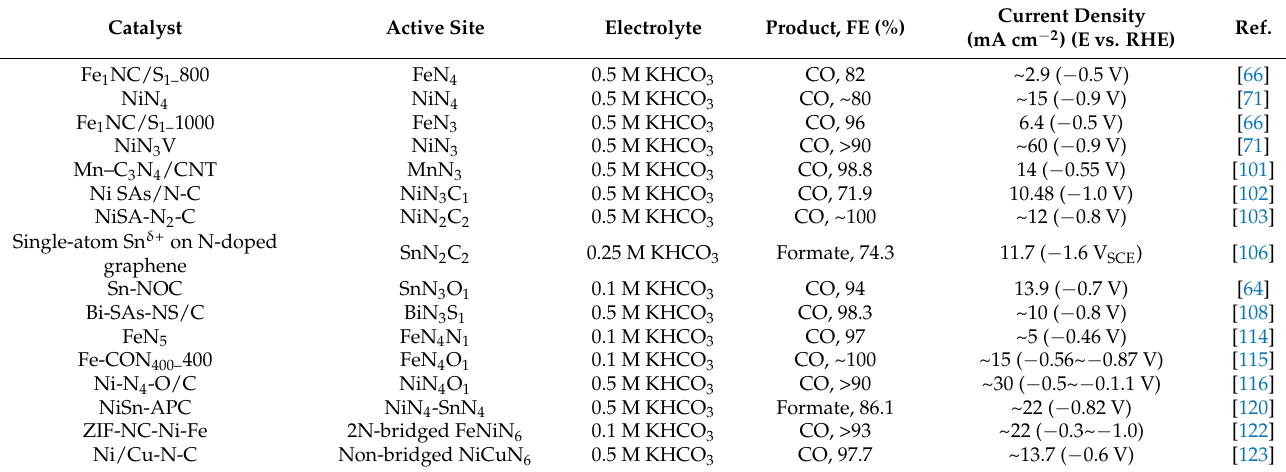
Table 1. The comparison of CO 2 RR performances of the SACs with different active